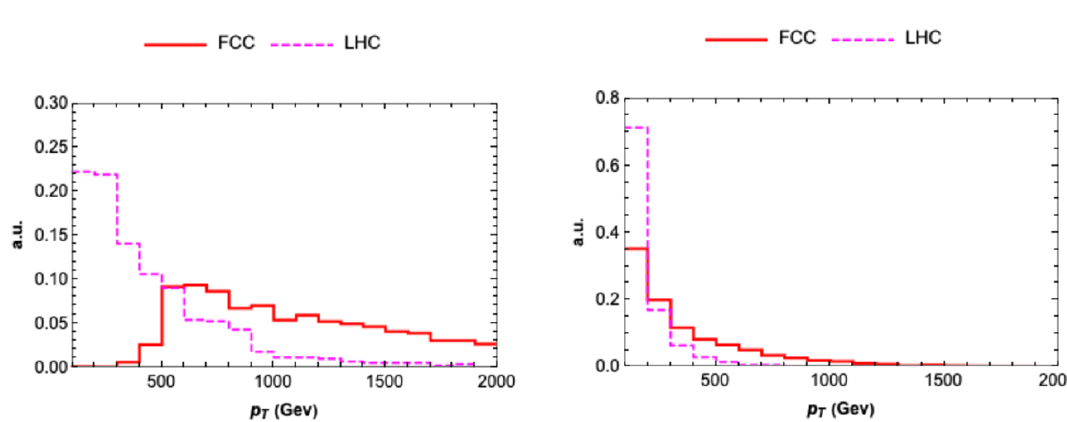
Figure 11 . Comparison of p T distribution for the jjja background between the HL-LHC and the FCC-hh. The left plot is for the leading p T photon and the right plot is for the sub-leading one.